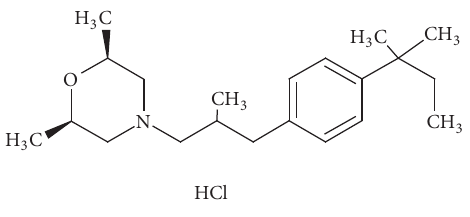
Figure 1: Amorolfine (AOF).